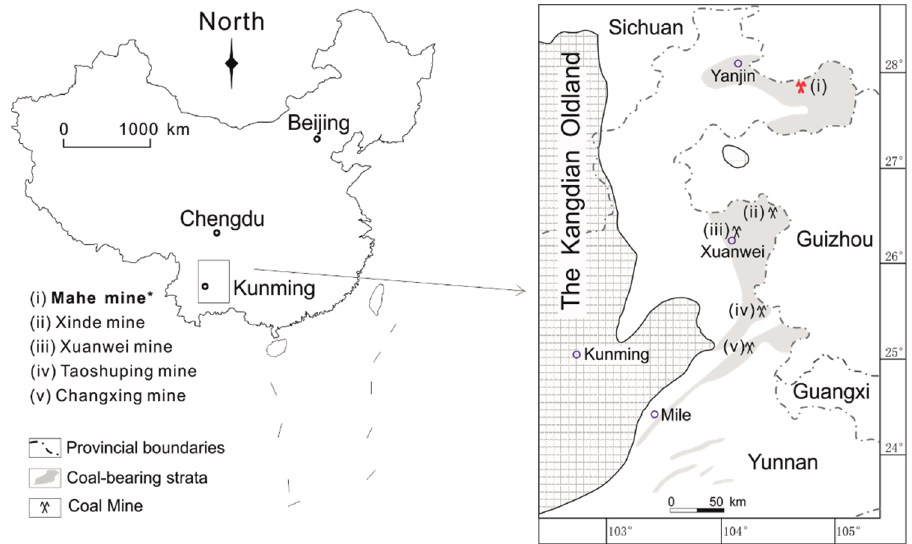
Figure 1. Location of the Mahe mine, Zhaotong coalfield, northeastern Yunnan Province, China, as well as locations of the Xinde, Xuanwei, Taoshuping, and Changxing mines, eastern Yunnan Province,